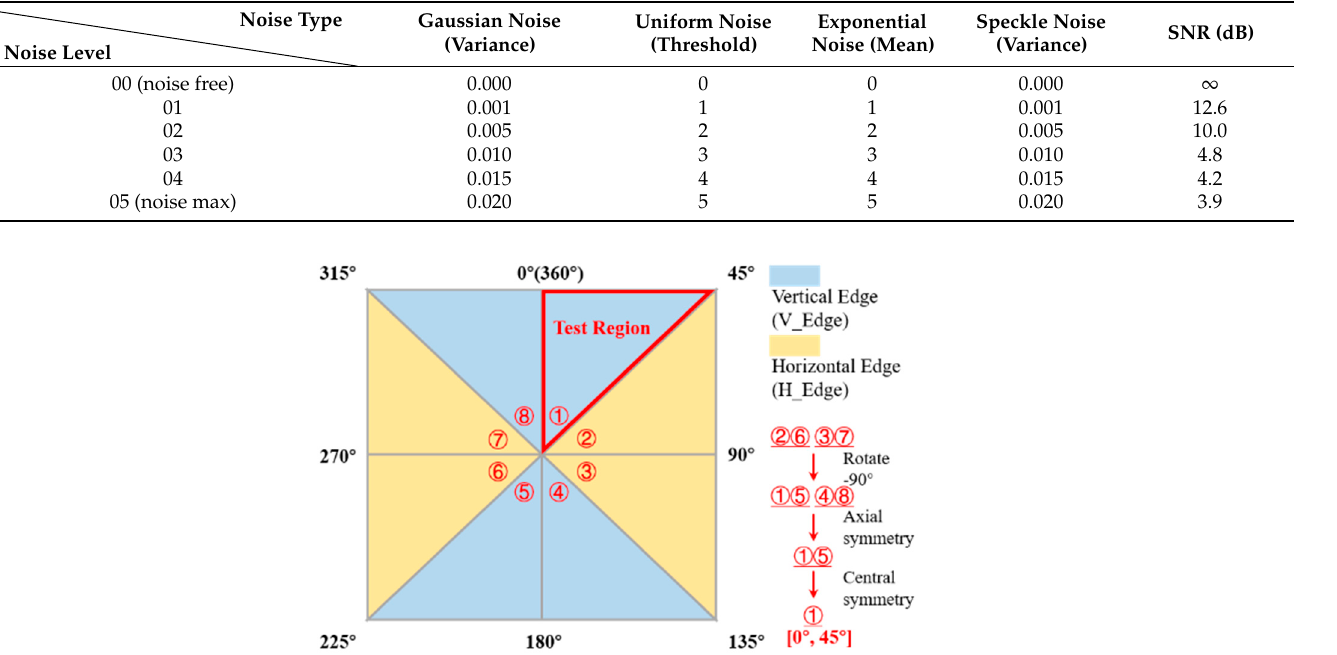
Table 2. Noise parameter and SNR of different noise levels for different noise types.